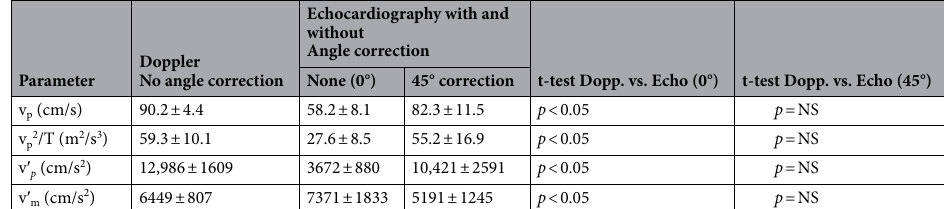
Table 2. Comparison of the four parameters derived from baseline aortic velocity signals measured simultaneously with DFVS and echocardiography.